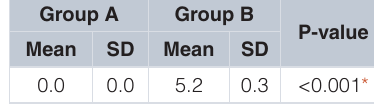
Table 1. Marginal gap formation (µm) between groups of teeth restored with different composites. Group A, treated with total-etch technique; Group B, treated with self-adhering resin composite. Mean and standard deviation (SD) values and results of Student’s t-test for the comparison between gap distances are shown